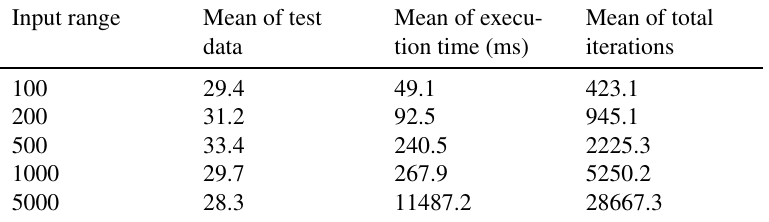
Table 5. Pa D 1, PopulationSize D 5, StepSize D 1, LTLThresholdValue D